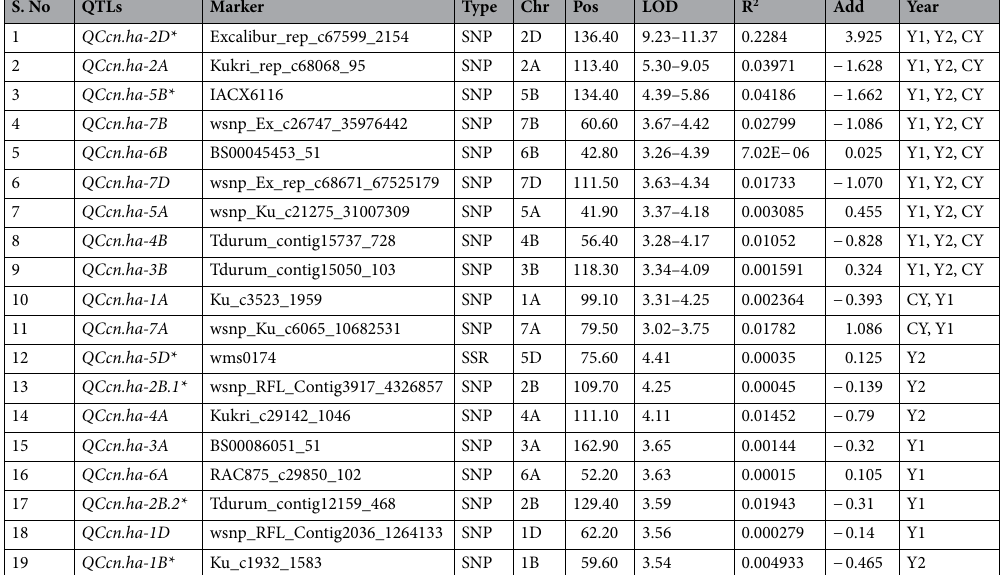
Table 1. List of QTLs detected for Heterodera avenae resistance using composite interval mapping (CIM) in the doubled haploid (DH) population. Chr: Chromosome; Pos: Position; cM): Centimorgan: LOD: Logarithm of the odds; R 2 : Phenotypic Variance (for S. No. 1–11, phenotypic variance of CY and for S. No. 12–19: phenotypic variance of individual year); Add: Additive Effect (for S. No. 1–11, additive effect of CY and for S. No. 12–19 additive effect for of individual year); Y1: Year 1, Y2: Year 2, CY: Combined year; Asterisk indicates QTLs colocalized or nearby to previously reported Cre genes, QTLs or MTAs for H. avenae or H.